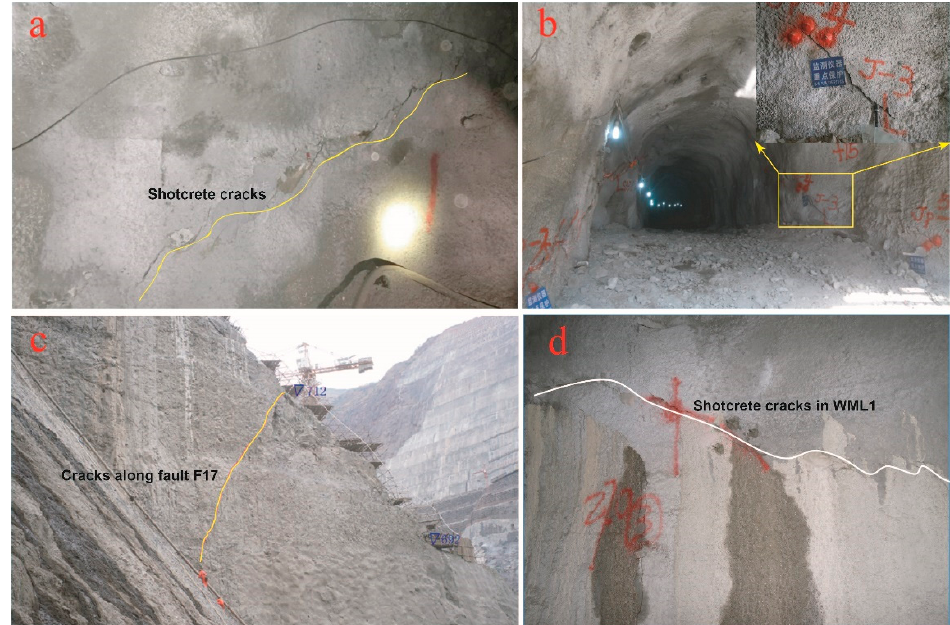
Figure 4. ( a ) Sprayed concrete cracks occurred at the sidewall of PSL2, ( b ) sprayed concrete spalling occurred at the peripheries of the entrances to WML2, ( c ) cracks occurred along fault F17 at the downstream slope of the spandrel groove, and ( d ) Sprayed shotcrete spalling occurred at the sidewall of